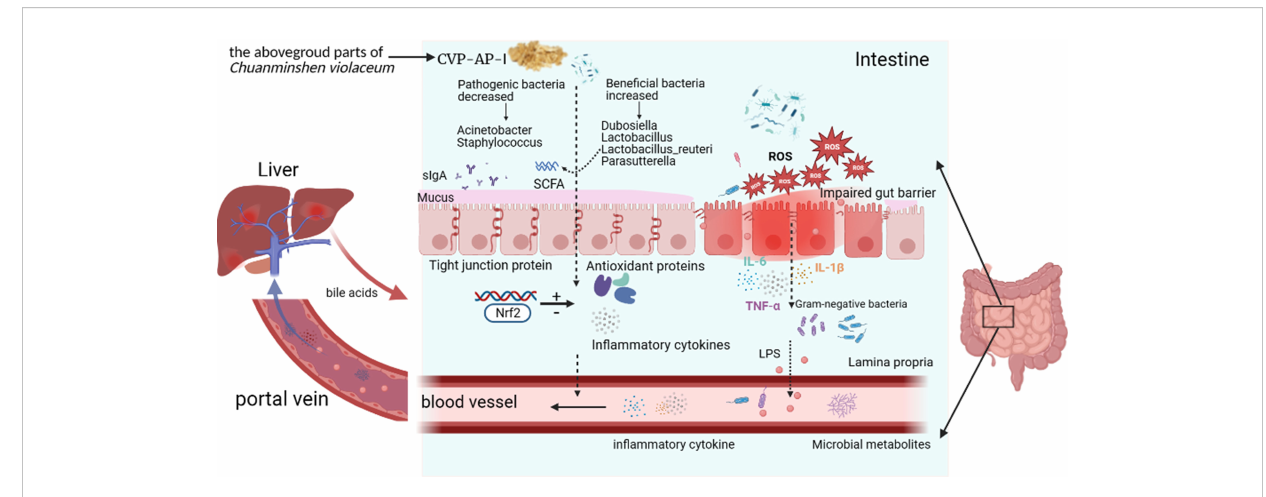
FIGURE 9 Summary diagram of the pharmacological effects of CVP-AP-I.